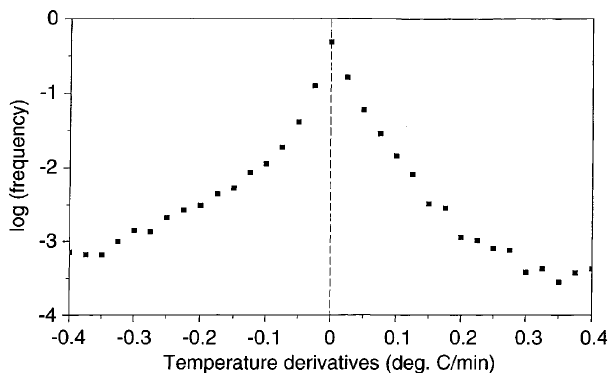
Fig. 3. Histogram of temperature time derivative, averaged over sensors 3, 5–8 and 11, for the period following the surge. The bin size (not shown) is 0.025 (cid:176) C/min wide and the logarithm of the frequency